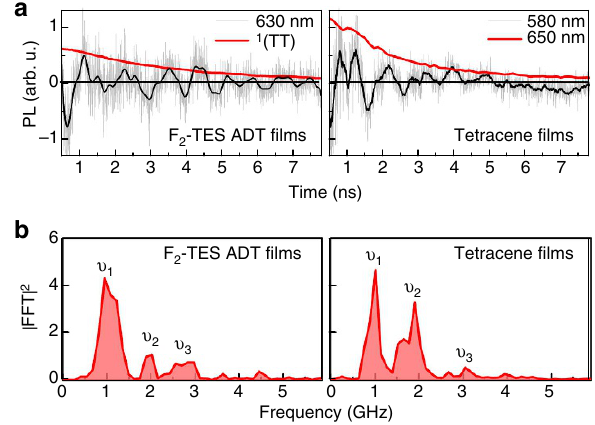
Figure 3 | PL quantum beating from spin-entangled 1 (TT). ( a ) PL decay of F 2 -TES ADTand tetracene films following femtosecond excitation at 300K, after subtraction of multi-exponential envelope. Resulting slow oscillations (grey: raw, black: smoothed) decay in agreement with extracted 1 (TT) kinetics in F 2 -TES ADT and red-emitting feature in tetracene (red). ( b ) Fourier transform of the oscillations, revealing quantum beats at 1.05, 1.96, 2.88 ± 0.1GHz (F 2 -TES ADT) and 0.99, 1.91 and 3.06 ± 0.1GHz